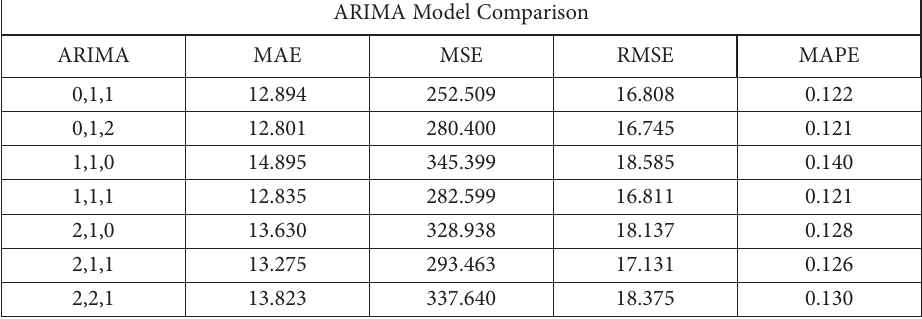
Table 2. ARIMA models correlogram results